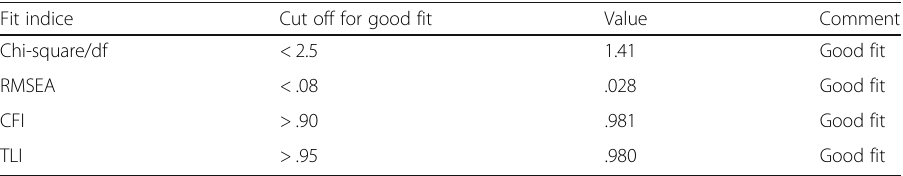
Table 3 Model-fit indices derived from second order